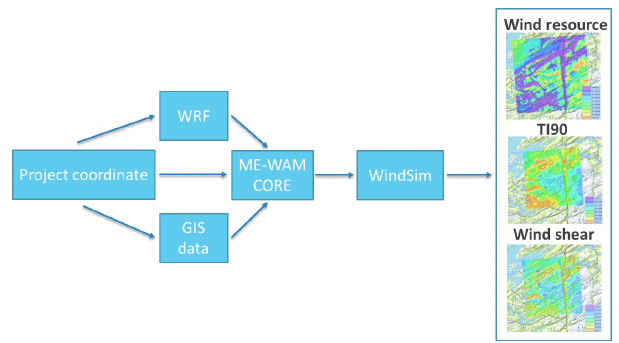
Figure 2. Schematic description of the ME-WAM model